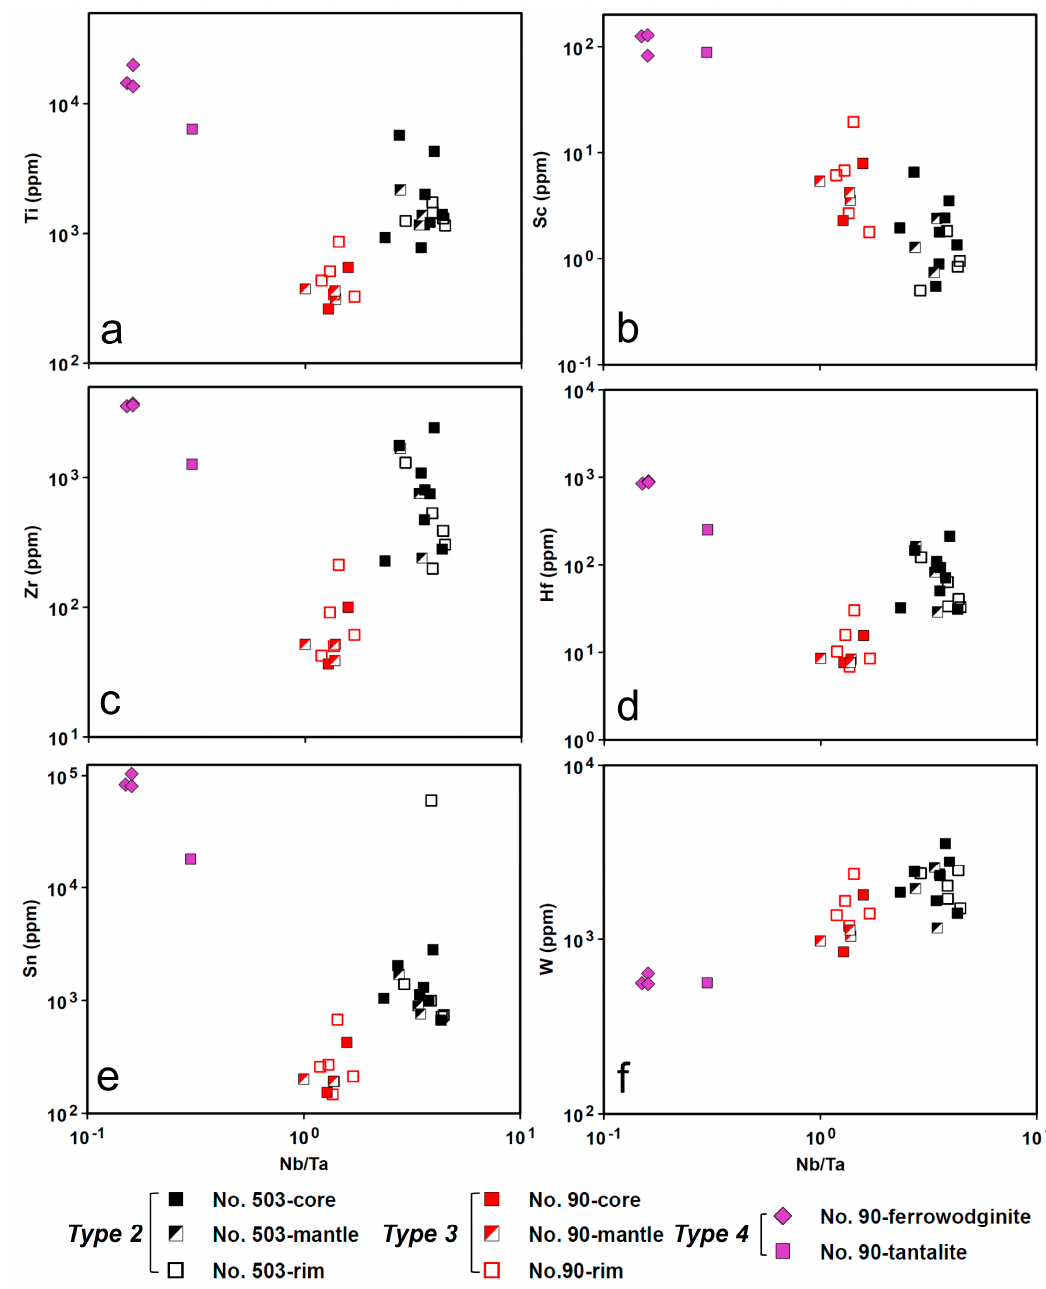
Figure 10. Binary plots of important trace elements versus Nb/Ta ratio for Nb-Ta oxides from No. 90 and 503 pegmatites based on the concentrations of these elements obtained using LA-ICP-MS. ( a ) Ti vs. Nb/Ta; ( b ) Sc vs. Nb/Ta; ( c ) Zr vs. Nb/Ta; ( d ) Hf vs. Nb/Ta; ( e ) Sn vs. Nb/Ta; and ( f ) W vs. Nb/Ta.